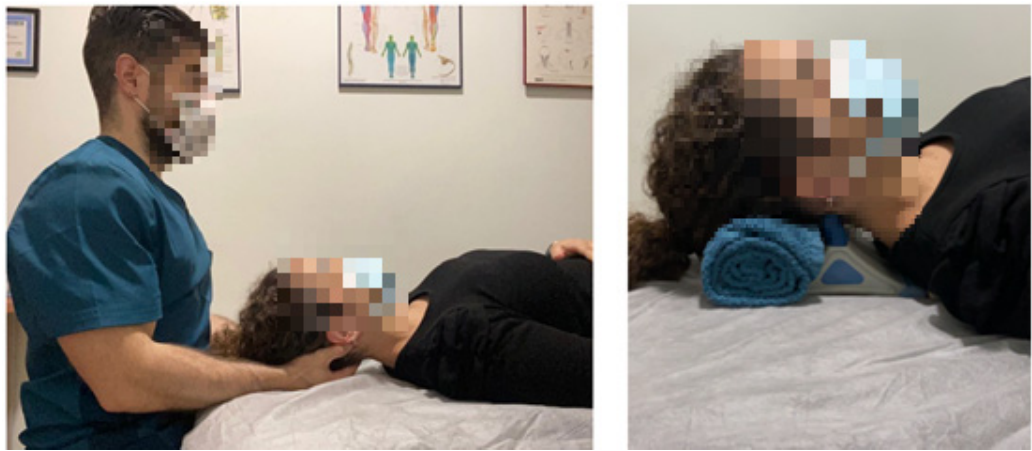
Figure 2. Manual suboccipital inhibition technique ( left picture ) and application of the INYBI ( right picture ).